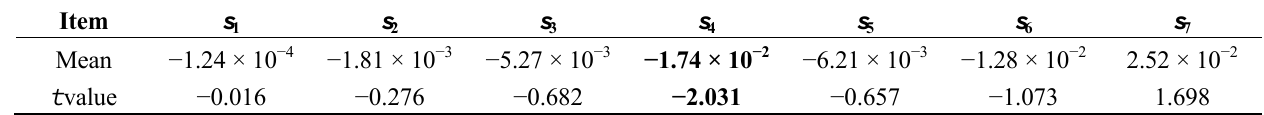
s and t value of DEC12. i